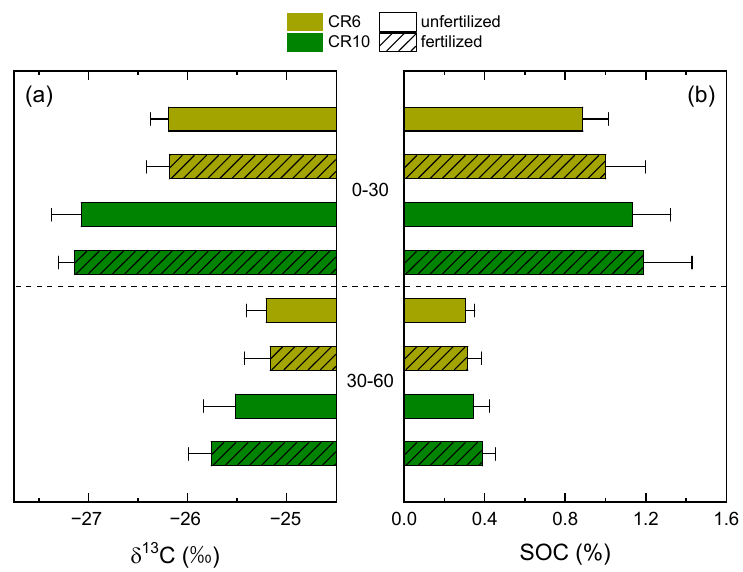
Figure 1. Isotope delta values ( a ) and contents ( b ) of soil organic carbon (SOC) in the 0–30 and 30–60 cm soil layers of CR6 (50% maize) and CR10 (no maize) after 16 years of differences in crop ro- tation and fertilization. Fertilized treatments received biogas digestate. Soil sampling was conducted in spring 2020. Error bars represent standard